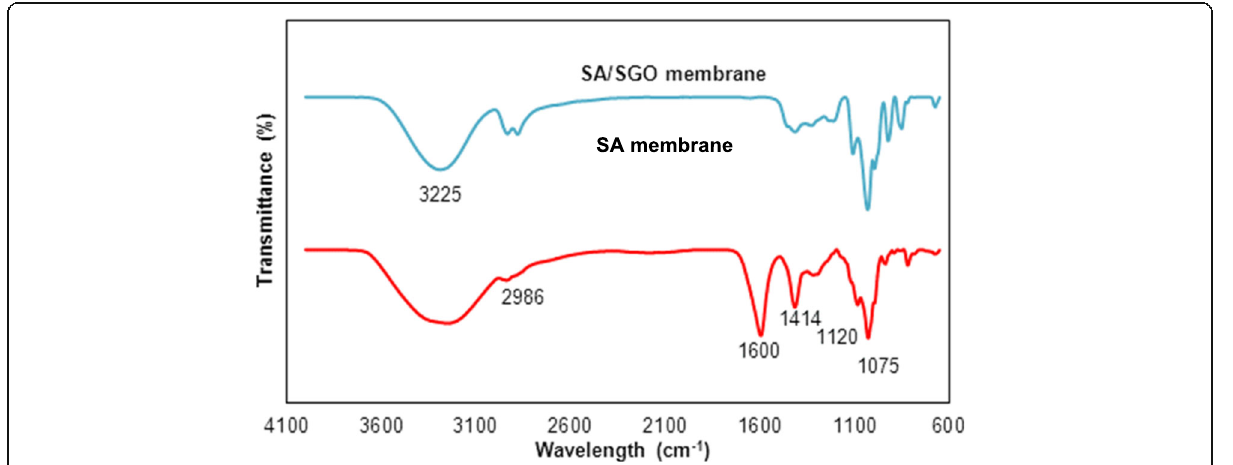
Fig. 6 FTIR spectra of SA and SA/SGO membrane